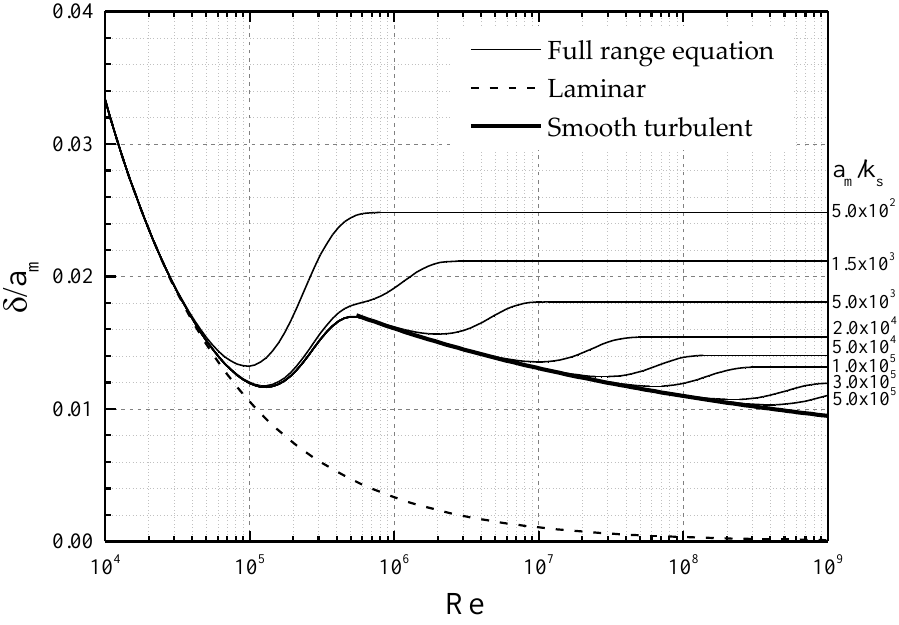
Figure 8. Wave boundary thickness using the full-range equation, Equation (27).